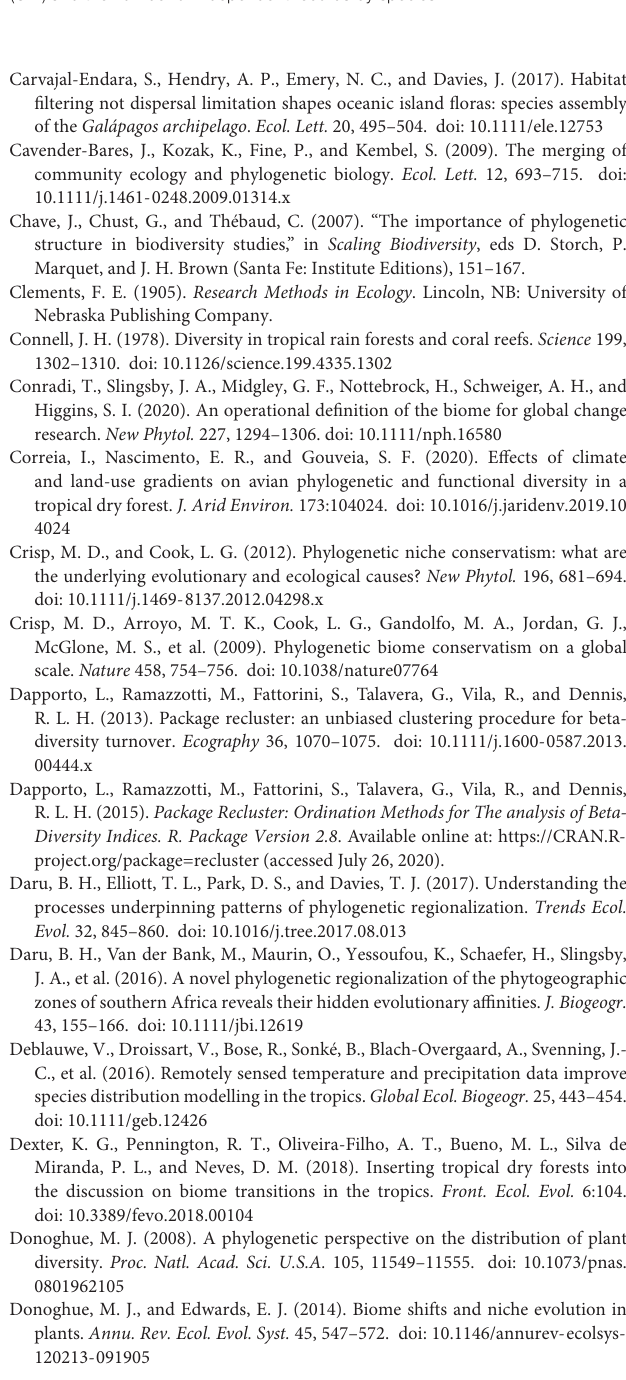
data. The black line indicates the limits of the Caatinga domain sensu Instituto Brasileiro de Geografia e Estatística [IBGE] (2012). Supplementary Figure 5 | Raster file used to produce Figure 4A that highlights the “core” Caatinga and associated transition zones. Supplementary Table 1 | Voucher details for DNA sequences newly generated in this study. Supplementary Table 2 | Species included in the analyses, including taxonomic family, functional traits, and model performance statistics. Supplementary Table 3 | The relationship between Continuous Boyce Index (CBI) and the number of independent records by